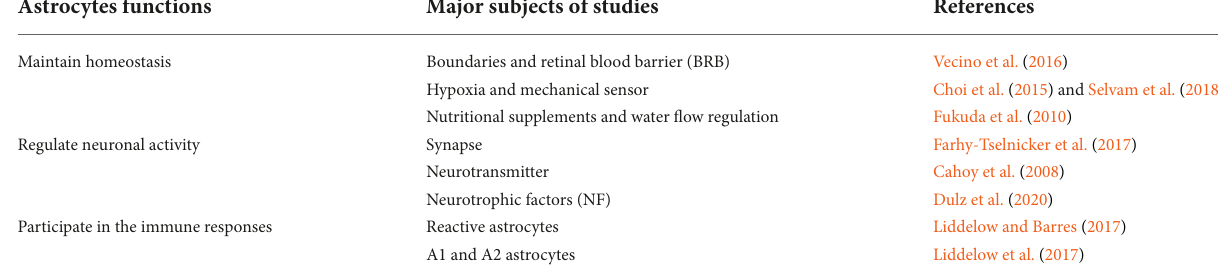
TABLE 1 Functions of